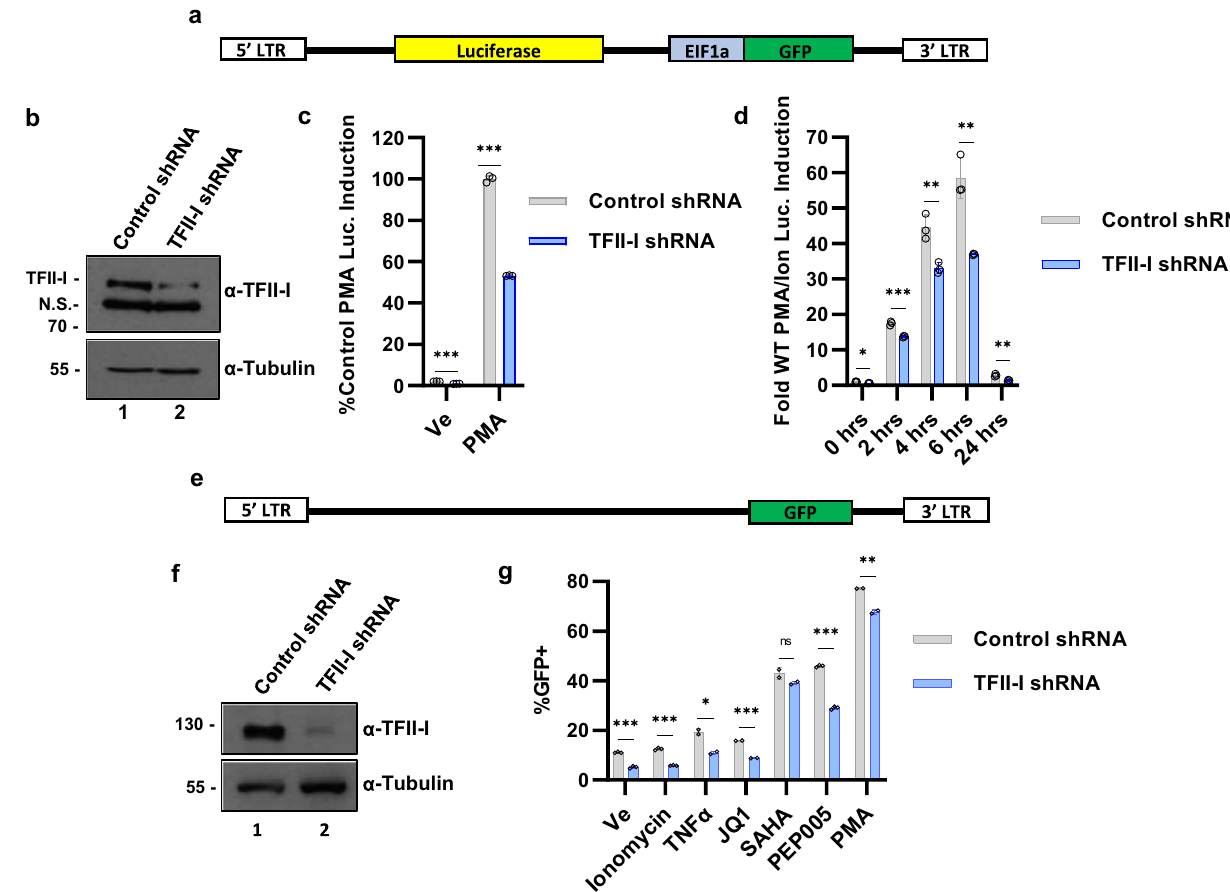
Fig. 1 TFII-I promotes HIV-1 expression. a Schematic representation of the reporter virus integrated into the Jurkat Tat mHIV-Luciferase cell line, where luciferase is expressed from the 5 ’ LTR as a fusion with p24 gag . b Jurkat mHIV-Luciferase cells were transduced with pLKO shRNA vector control (lane 1) or TFII-I shRNA expressing lentivirus (lane 2). Immunoblots were performed on whole-cell lysates prepared 8 days post puromycin selection, with antibodies against TFII-I or Tubulin. c Jurkat mHIV-Luciferase cells transduced with control shRNA or TFII-I shRNA expression vectors were left untreated (Ve, DMSO) or stimulated with 20 nM PMA for 4 h prior to measuring luciferase activity ( n = 3, mean ± SD). d Transduced Jurkat mHIV-Luciferase cells were treated with 20 nM PMA/1 µ M ionomycin for the indicated time prior to measuring luciferase activity ( n = 3, mean ± SD). e Schematic representation of the Jurkat-based JLat10.6 HIV-1 proviral cell model, where Nef is replaced with GFP and the virus is rendered replication incompetent by a mutation within Env . f JLat10.6 cells were transduced with empty Control shRNA vector (lane 1) or TFII-I targeting shRNA (lane 2). Following selection with puromycin for 4 days, whole-cell lysates were collected and analyzed by western blot using antibodies against TFII-I or Tubulin. g Four days later — shRNA infection- transduced JLat10.6 cells were treated with DMSO (Ve), 1 µ M ionomycin, 10 ng/ µ L TNF α , 10 µ M JQ1, 10 µ M SAHA, 10 nM PEP005, or 10 nM